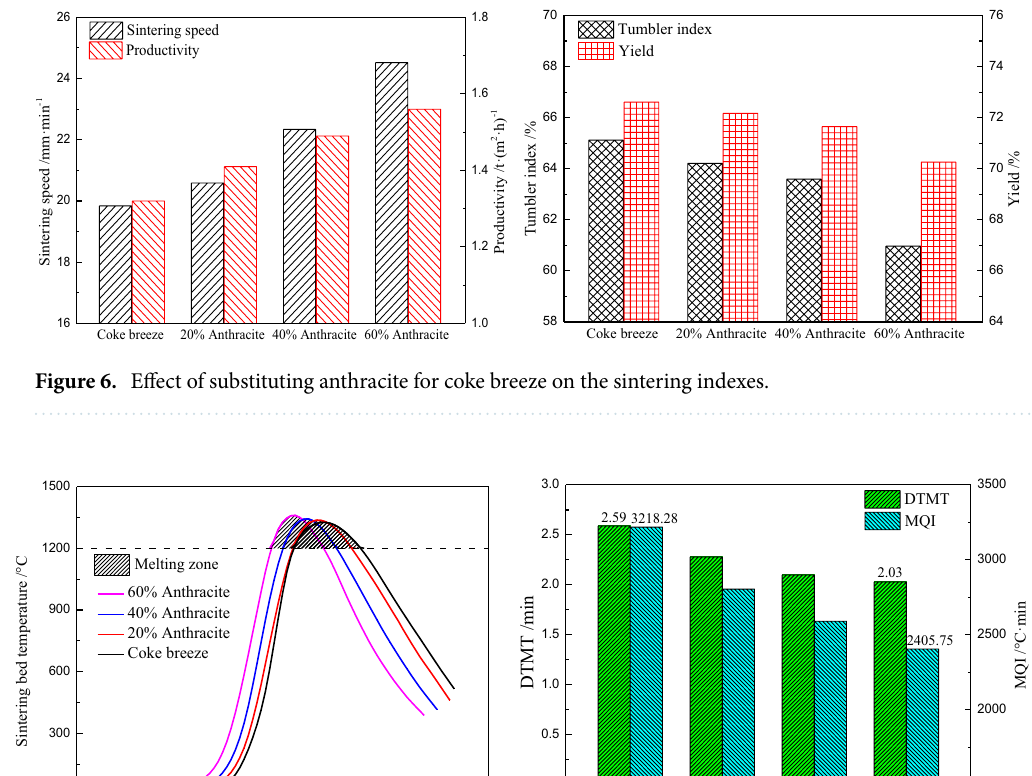
amounts of anthracite for coke breeze does not have a negative influence, when the initial sinter bed permeability is the same. Effect on sintering quality. The influence of substituting anthracite for coke breeze on sintering index is shown in Fig. 6. Compared with the base trial where only coke breeze was used, the sintering speed increased from 19.84 to 24.52 mm min −1 as the proportion of anthracite substitution increased. The improvement of the sinter- ing speed was positively correlated with the shorter combustion time of the anthracite. The sinter yield worsened to a small extent, decreasing from 72.61 to 70.26%, which still meets the production requirement for the labora- tory sintering experiment. Taking the sintering speed increase and the yield decrease into consideration, based on our calculations, substituting anthracite for coke breeze improves the productivity by 18.18%. However, the last important indicator, that is, the tumbler index, deteriorated significantly when the replacement percentage reached 60%. For a substitution proportion of 40%, the sinter tumbler index retained at 63.59%, which satisfies the quality requirements. To achieve ideal sintering indexes, the proportion of anthracite substituted for coke breeze should not exceed 40%. Effect on the thermal characteristic of the sintering bed. The effect of substituting anthracite for coke breeze on the thermal characteristic of the sintering bed was investigated at a position of 200 mm from the top of the sinter pot. The results are shown in Fig. 7. As can be seen from the temperature curves, the sinter bed temperature increased rapidly to the maximum value in about3 min, and then, it decreased relatively slowly because of the heat exchange with the suction air. Due to the different combustion characteristics of anthracite and coke breeze, the maximum temperature was reached in advance because the flame front speed increased with increasing anthracite dosage, which expedited the sintering speed. The faster combustion reactivity of anthracite resulted in a higher maximum temperature and a shorter sintering duration time, which decreases the sinter quality. As the anthracite substitution ratio increased from 0 to 60%, the melting temperature duration time decreased from 2.59 to 2.03 min, and the melt quantity index decreased from 3218.28 to 2405.75 °C·min. The main reactions involve the sintering process, are listed in Eqs. (5)–(10), and the characteristics and melt- ing temperatures of the fusible compounds and the eutectic mixtures are presented in Table 4 33 . Hematite (Fe 2 O 3 ), fayalite (2FeO·SiO 2 ), dicalcium silicate (2CaO·SiO 2 ), calcium ferrite (CaO–Fe 2 O 3 ) and compound calcium fer- rite (CaO–SiO 2 –Fe 2 O 3 ) are the main mineral phases formed in the sintering process. The fayalite, dicalcium